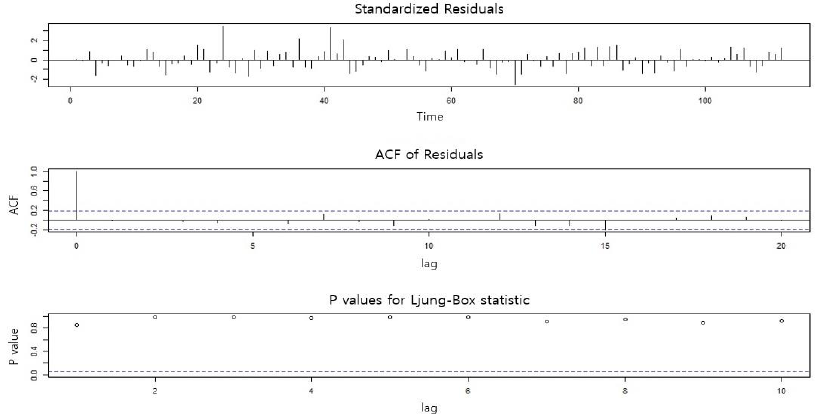
Figure 6. Fitted model for scrap throughput.